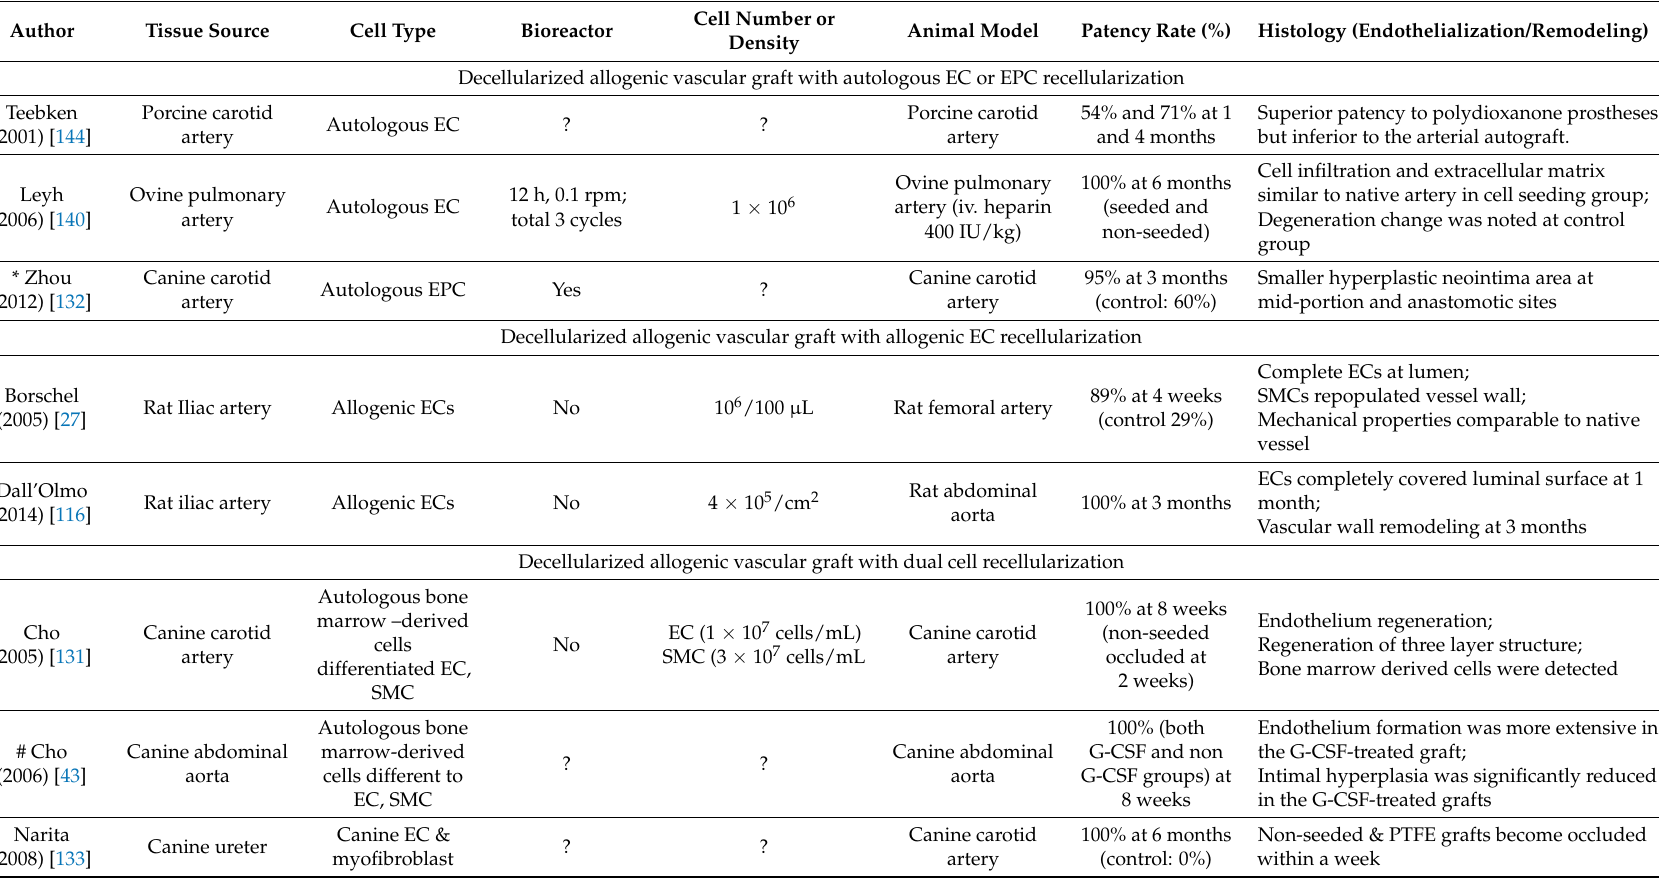
Table 4. Summary of in vivo performance of recellularized-decellularized vascular grafts since